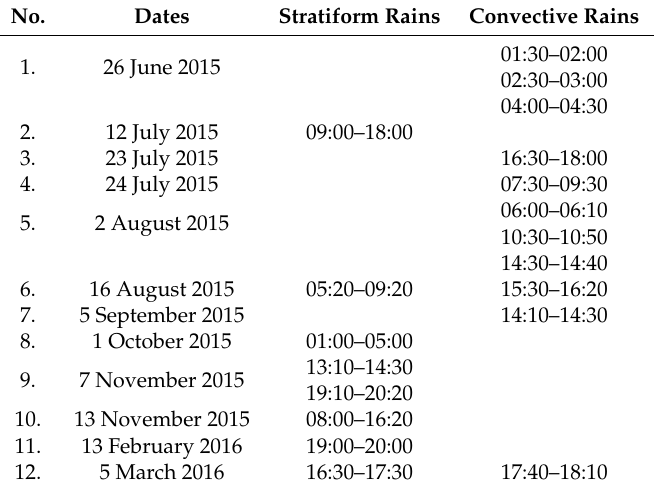
Table 1. Data sampling used in the study: 12 days from June 2015 to March 2016 by the VPR method (Stratiform rains: appearance of bright band and Convective rains: radar reflectivity ≥ 30 dBZ). No. Dates Stratiform Rains Convective Rains